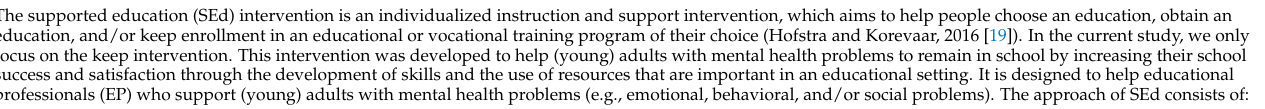
Table 1. The supported education intervention for adolescents in secondary